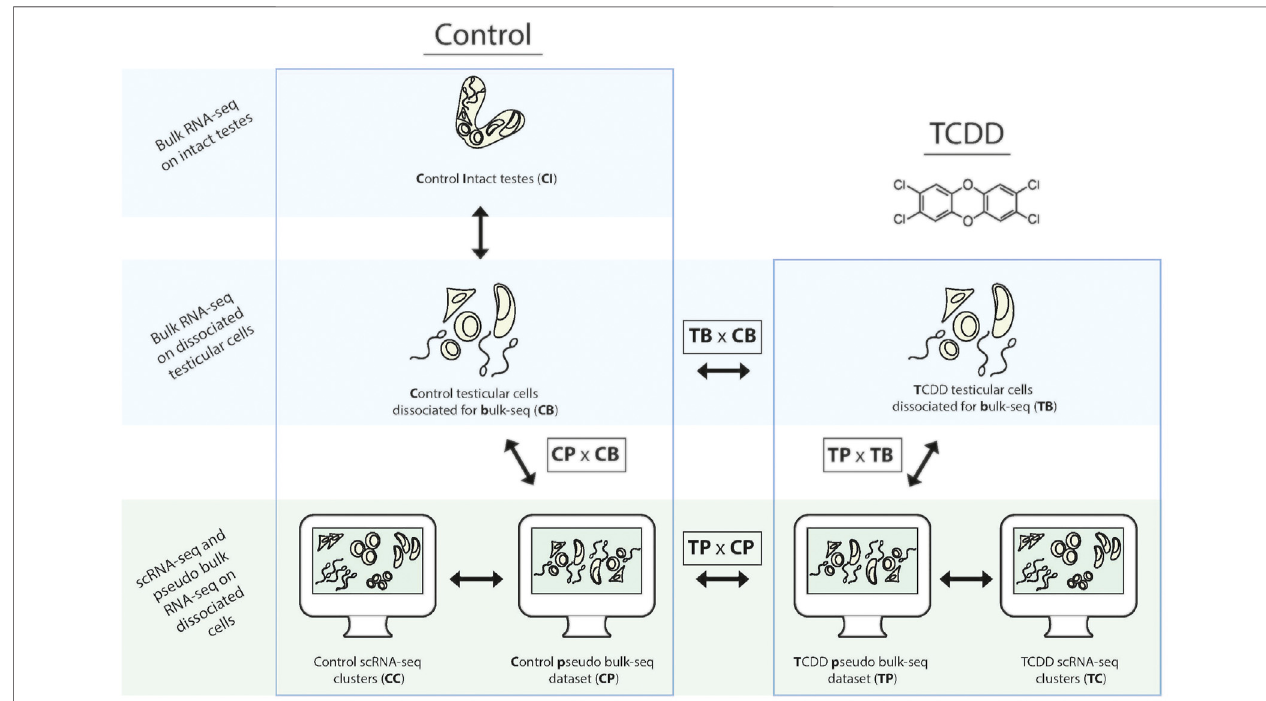
FIGURE 1 | Schematic of the comparative transcriptomic analyses from each method and associated tissue preparation. To determine baseline effects of dissociation,pairedsamplesofintactanddissociatedtestesweretakenforbulk-seq.Bulk-seqofcontrol(CB)andTCDD-exposeddissociatedtestes(TB)(middlepanel) were compared to pseudo bulk-seq of paired dissociated samples that underwent scRNA-seq (CP, TB) (lower panel, middle images). Pseudo bulk-seq samples were compared to their scRNA-seq cluster complement (lower panel, outer images).